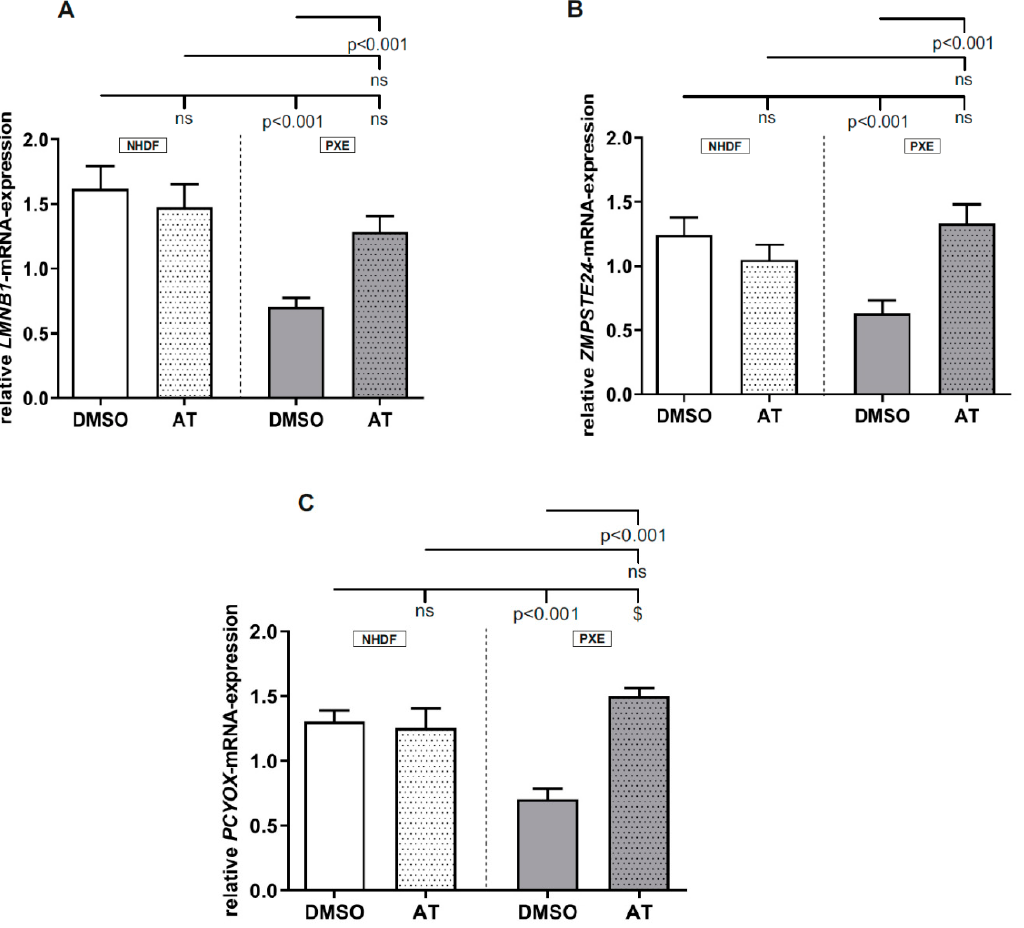
Figure 2. Relative LMNB1 , ZMPSTE24 and PCYOX mRNA expression of PXE fibroblasts and NHDFs. Fibroblasts were cultivated for 72 h in 10% LPDS medium or medium with 10% LPDS and 20 µ M AT. ( A ) Relative LMNB1 mRNA expression PXE fibroblasts (gray, n = 3) and NHDFs (white, n = 3). ( B ) Relative ZMPSTE24 mRNA expression of PXE fibroblasts (gray, n = 3) and NHDFs (white, n = 3). ( C ) Relative PCYOX mRNA expression of PXE fibroblasts (gray, n = 3) and NHDFs (white, n = 3). n =